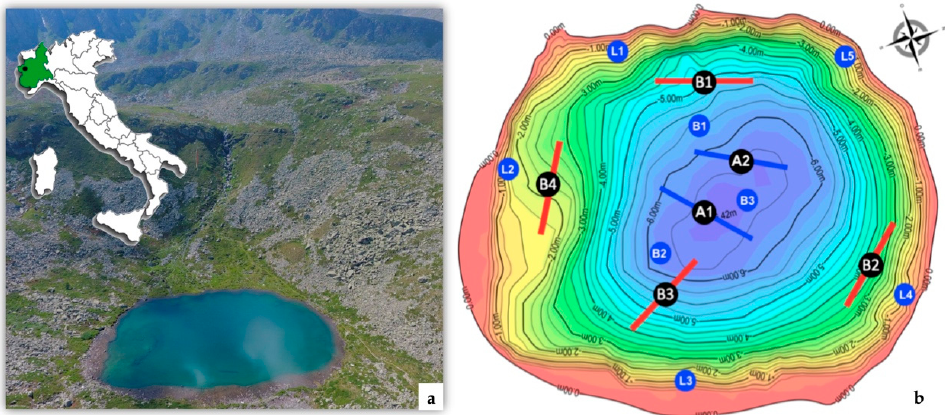
Figure 1. ( a ) Location of Balma Lake (northwest Italy). ( b ) Water sampling sites and gillnet placement.